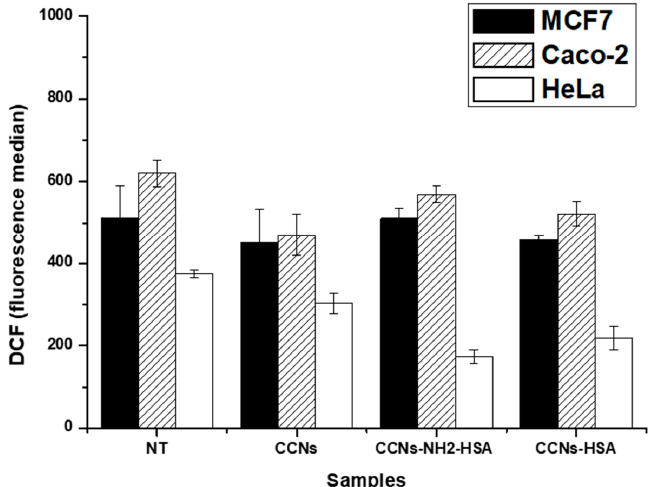
Figure 8. Reactive Oxygen Species (ROS) fluorescence intensity measured in MCF7 (black histogram), Caco-2 (patterned histogram) and HeLa (white histogram) cells. The experimental conditions are non-treated cells (NT), naked CCNs, CCNs-NH 2 -HSA and CCNs-HSA. Data were obtained from replicate experiments (n = 3).